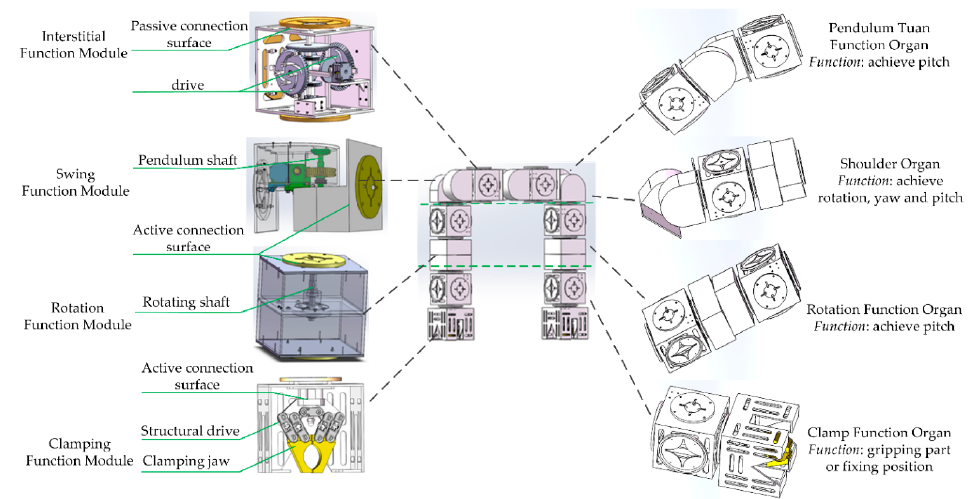
Figure 1. Module composition of the self-reconfiguring robot.